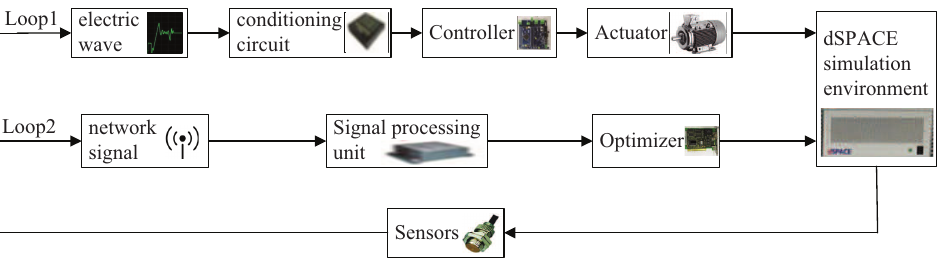
Figure 17. Hardware-in-the-loop (HIL) simulation